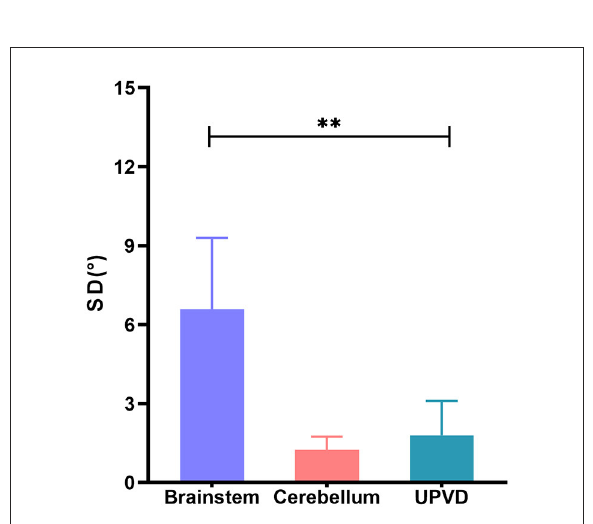
FIGURE3 Comparison of SD of brainstem, cerebellum, and UPVD groups. SD, skew deviation; UPVD, unilateral peripheral vestibular disorders. **p < 0.05.